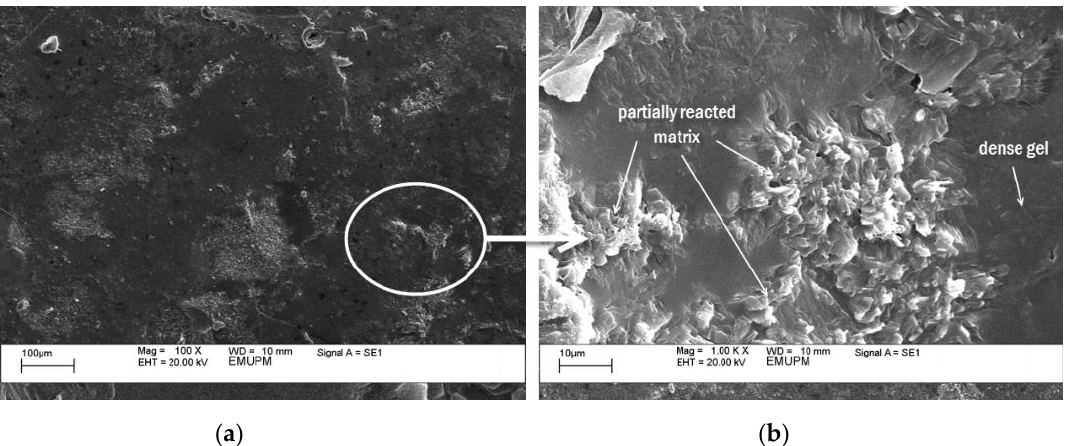
Figure 11. SEM micrograph of geopolymer binder with the highest adhesion strength (sample S17). ( b ) is the magnification of ( a ).